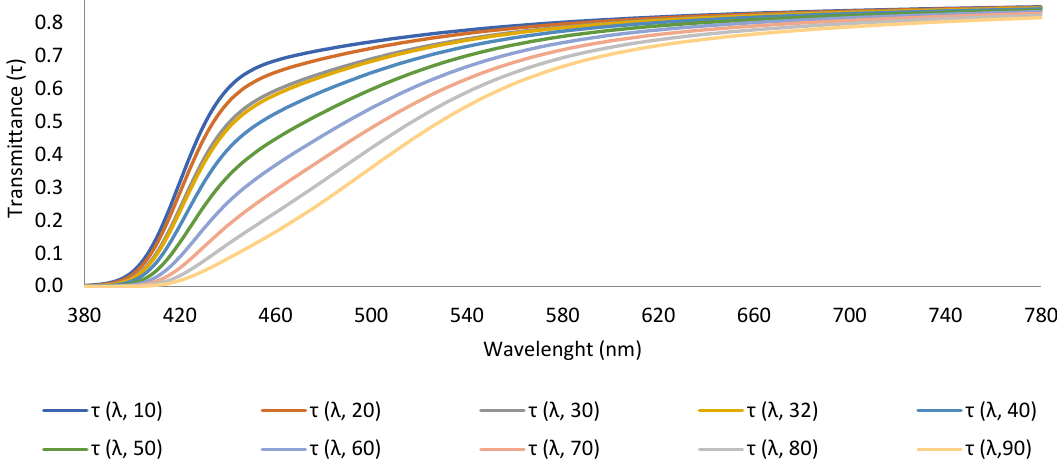
Figure 1. Spectral transmittance of the crystalline lens depending on age; τ ( λ ,Y), being Y = years. This figure shows the transmittance for each decade of life, taking a 32-year-old subject as the standard. It can be observed that the older the individual, the more absorbed the lower wavelengths become by the crystalline lens. Reproduced from [2].